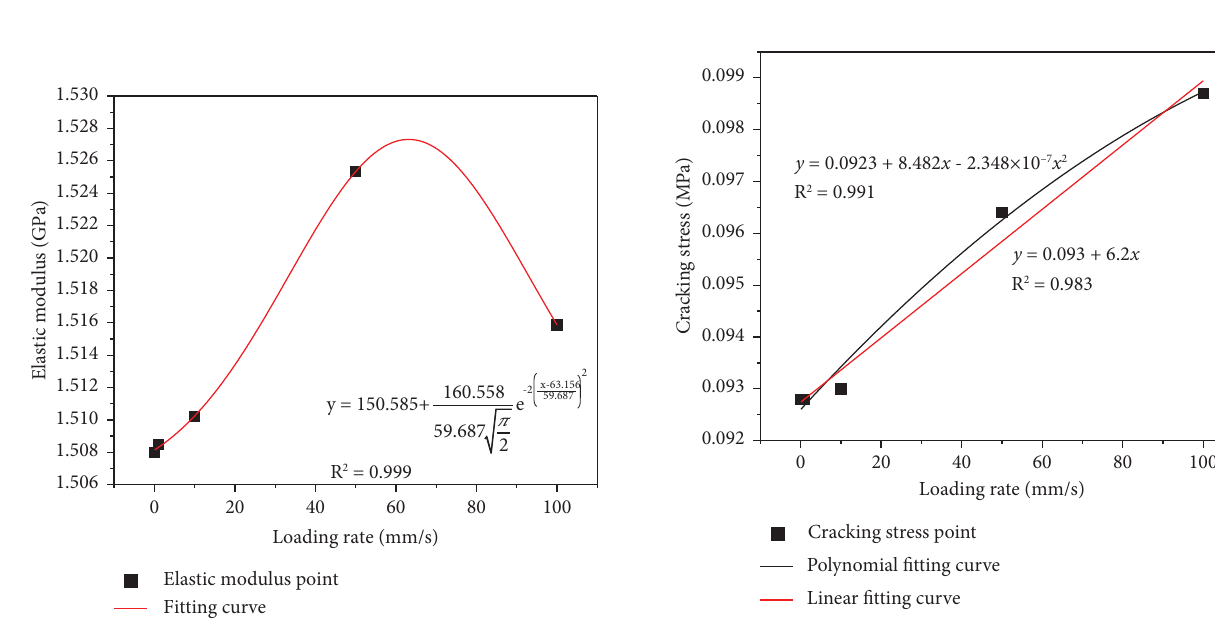
Figure 6: Elastic modulus change curve.